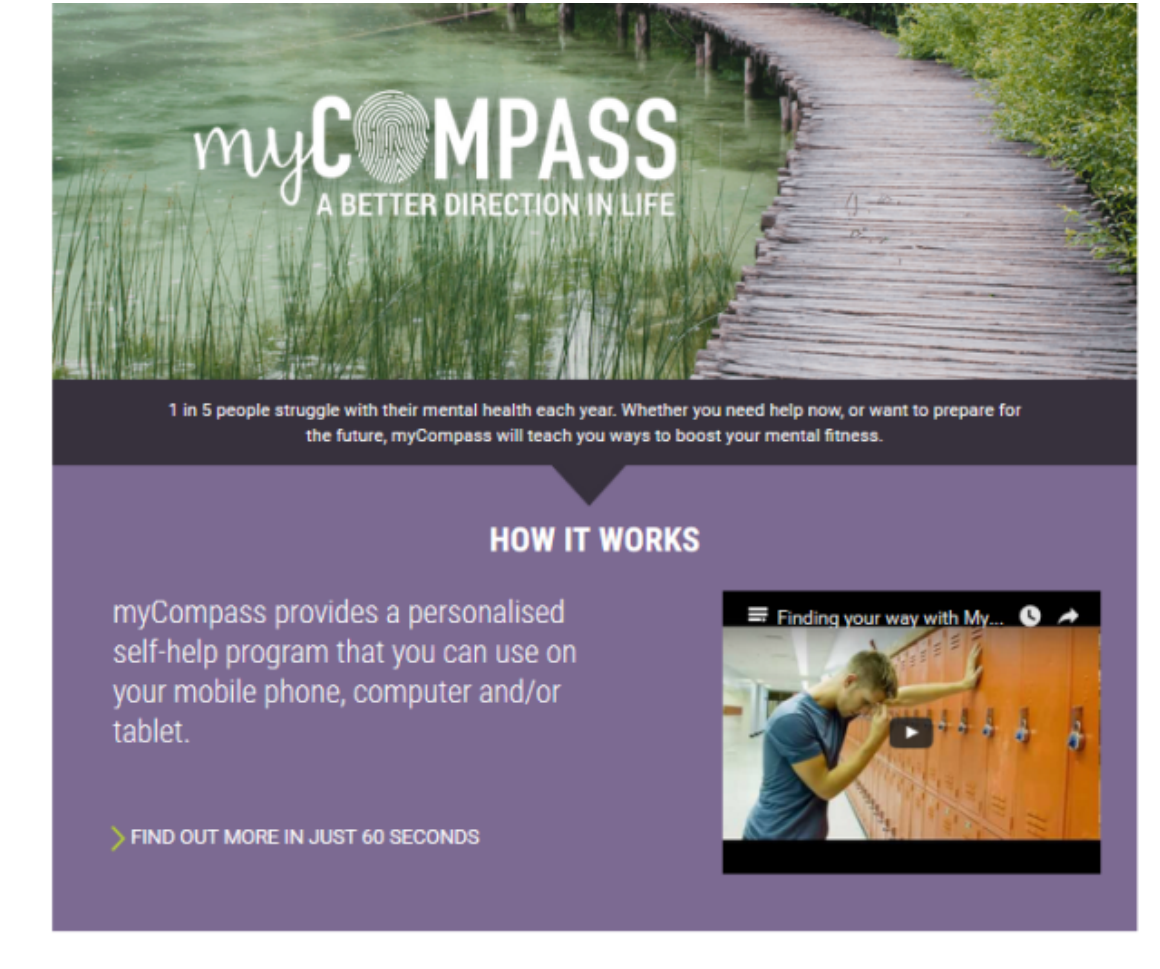
Figure 1. Screenshot of the myCompass landing